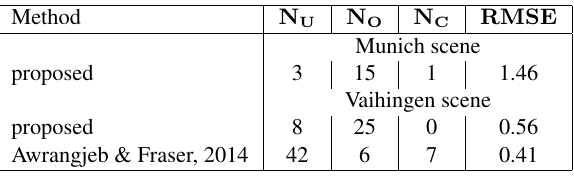
Table 3. Under- and oversegmentation and accuracy of the seg- mentation. Segmentation results of the Vaihingen Scene are com- pared to the results of Awrangjeb and Fraser (2014).